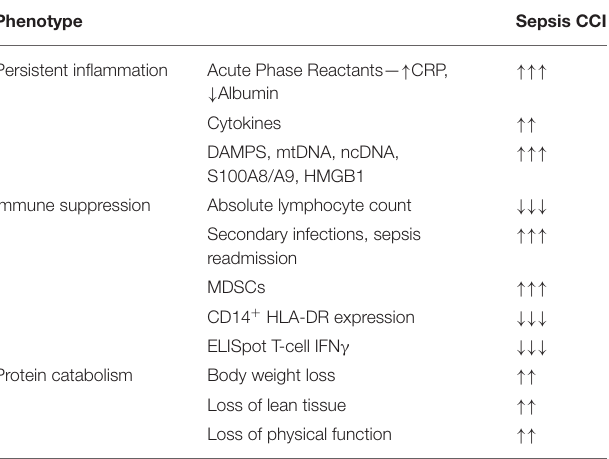
TABLE 1 | CCI phenotype in severe trauma and sepsis